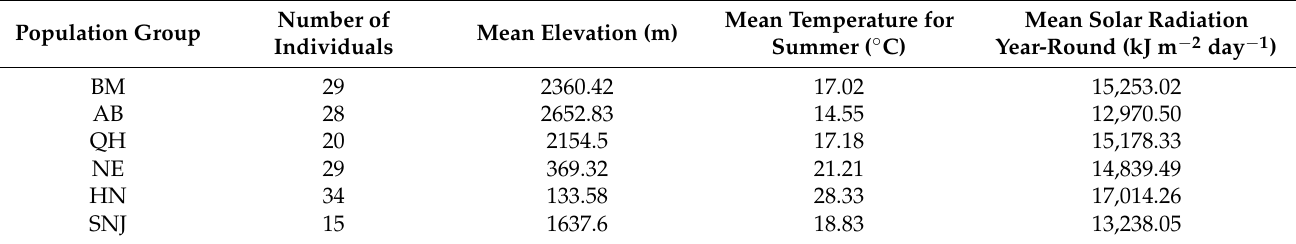
Table 1. Number of sequenced Asian honeybees for each population